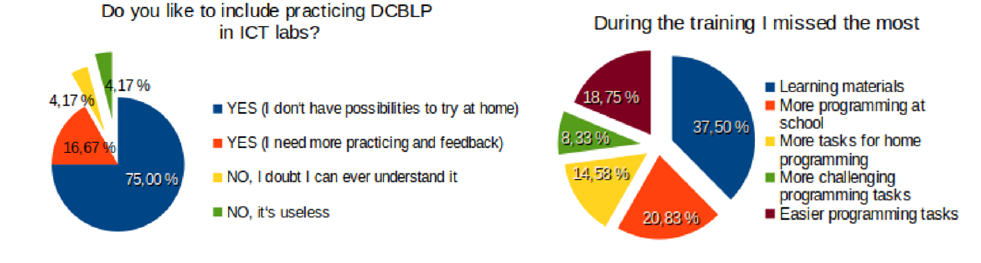
Figure 11. Questions related to practicing and missing training